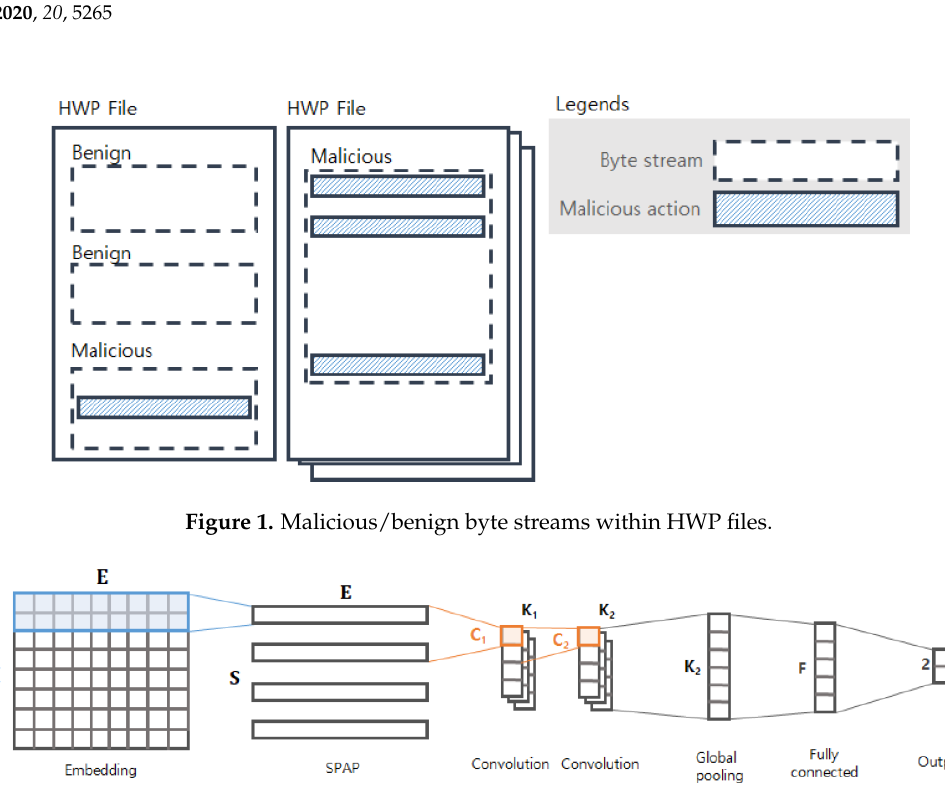
Figure 2. Graphical structure of the proposed